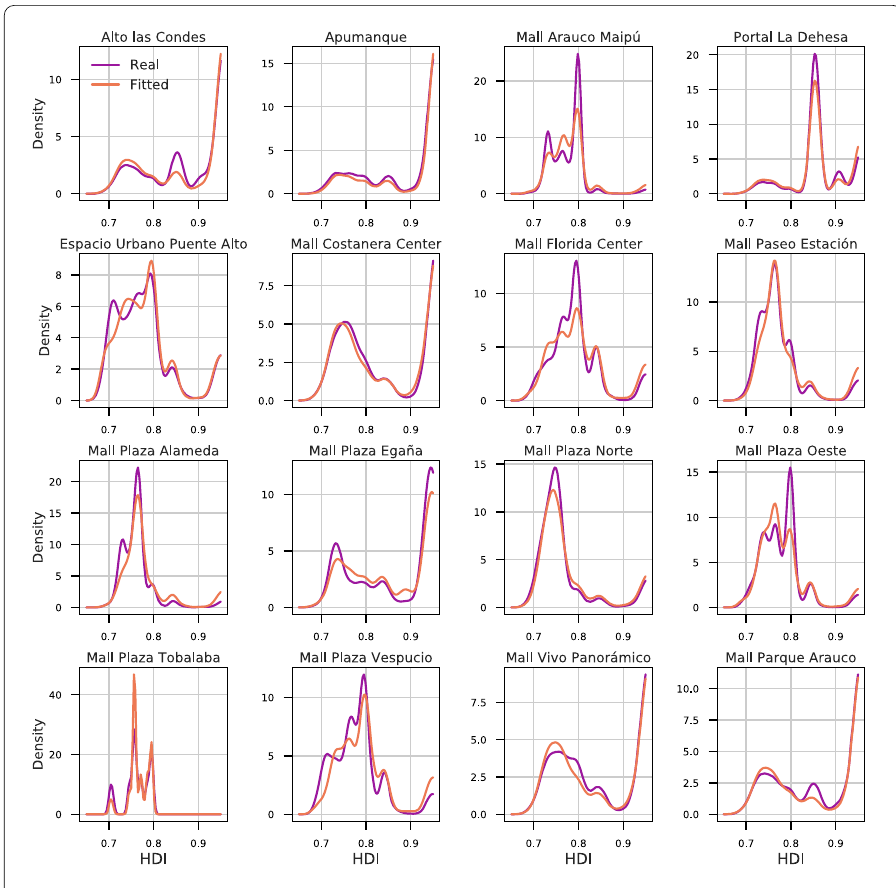
Figure 9 Kernel Density Estimation of the HDI index distribution of customers visiting each mall, according the XDR data (purple) and to the fitted gravity model in terms of the influx of people from different comunas (orange). KDE bandwidth was set to